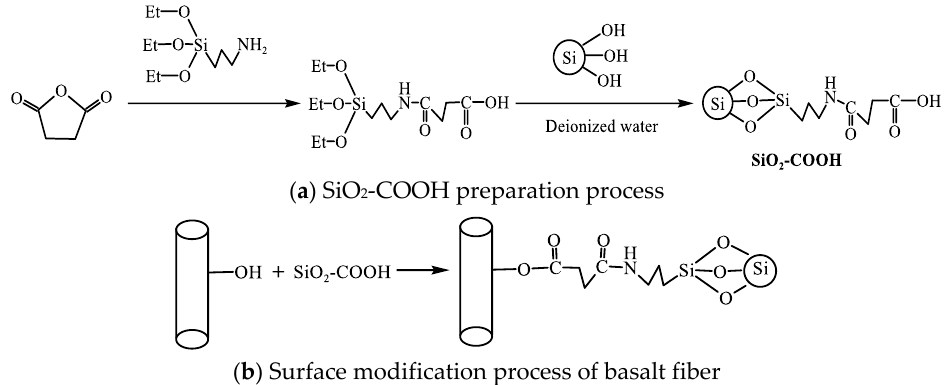
Figure 1. Principle of chemical reaction. ( a ) SiO 2 -COOH preparation process. ( b ) Surface modification process of basalt fiber.